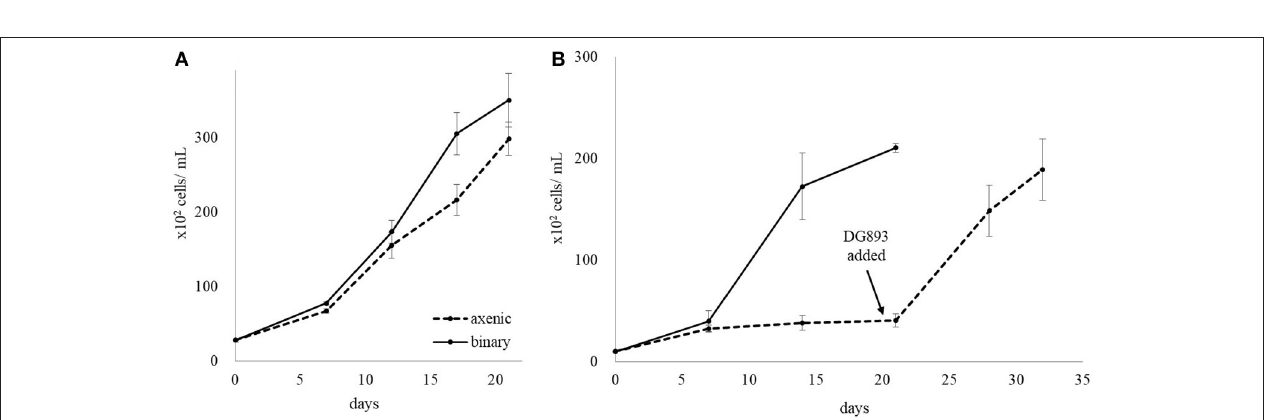
FIGURE 3 | Rescue of L. polyedrum by addition of DG893. (A) First generation of L. polyedrum growth maintained in L1 media either “axenic” or co-cultured with DG893. (B) Growth of L. polyedrum in the second subculture either “axenic” or co-cultured with DG893. After the second subculture of “axenic” L. polyedrum was incubated under the standard growth conditions for 21 days, an inoculum containing approximately 10 2 cells/mL of DG893 was added and incubation continued for an additional 14 days.